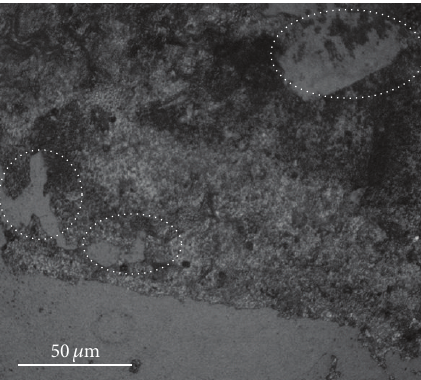
Figure 8: An optical micrograph of CZTS film after electrochemical testinchromiumchloridesolution;damagedfilmcanbeseenwithin encircled area.